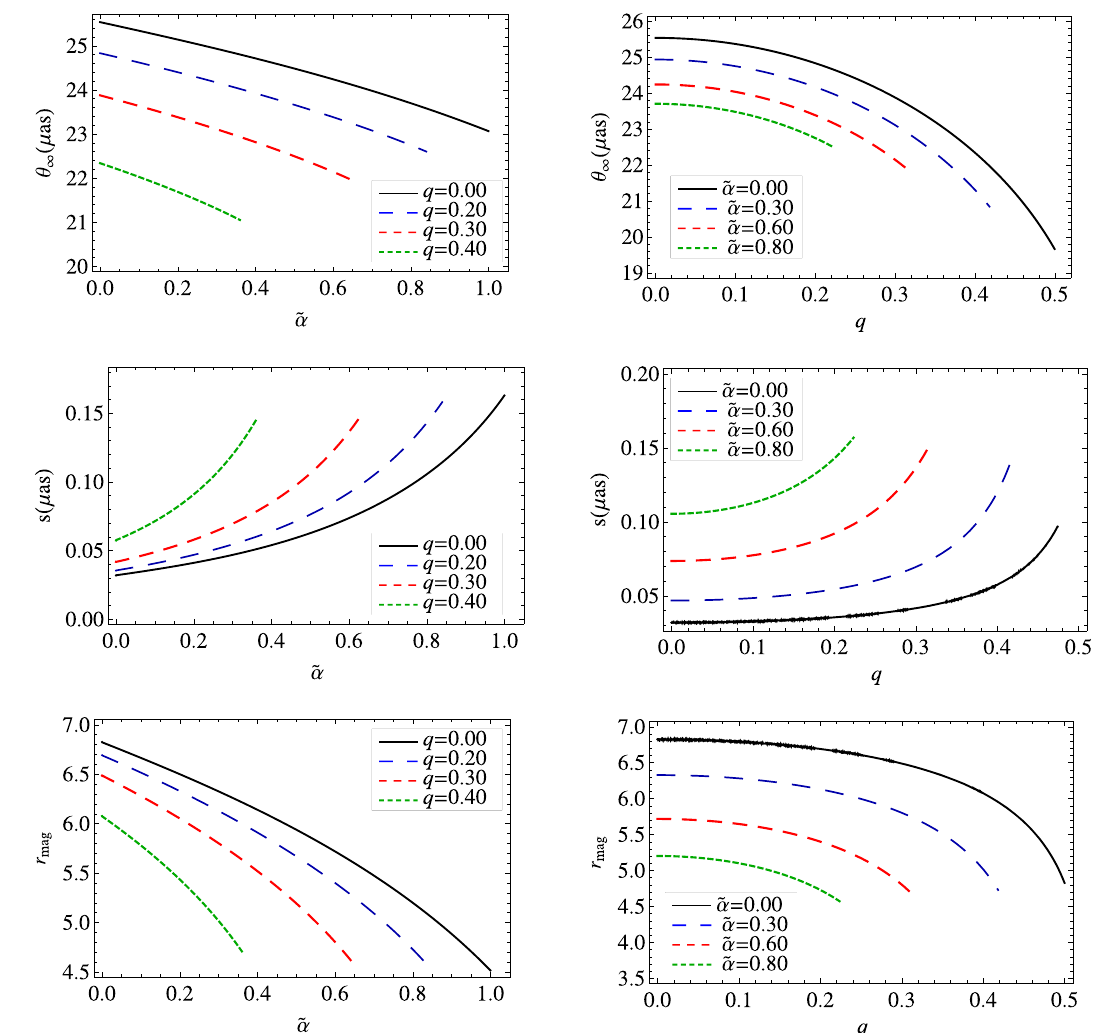
Fig. 9 Plots showing the behavior of strong lensing observables θ ∞ , s , and r mag as a function ˜ α (Left panel) and q (Right panel) for Sgr A* black